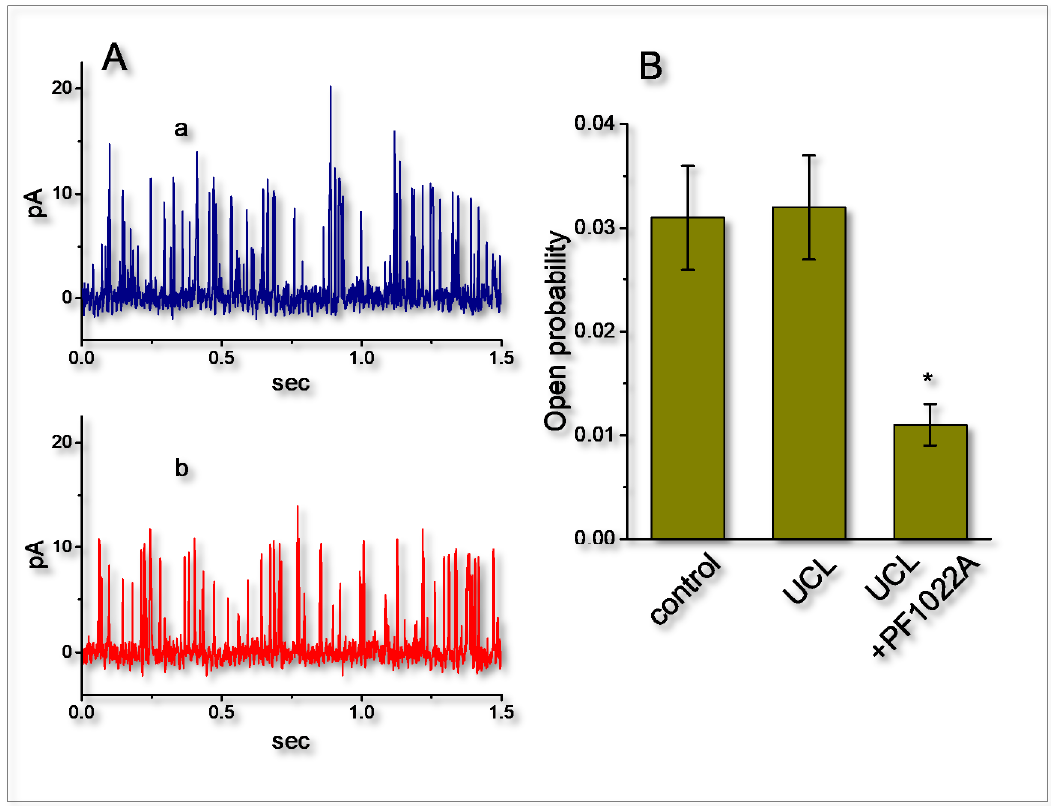
Figure 6. Failure of UCL-2077 to perturb the activity of BK Ca channels functionally expressed in GH 3 cells. In these experiments, inside-out current recordings were made, cells were bathed in high-K + , Ca 2 + -free solution, bath solution contained 0.1 µ M Ca 2 + and the examined cell was held at + 60 mV. ( A ) Original BK Ca -channel currents obtained in the absence (a) and presence (b) of 10 µ M UCL-2077. The upward deflection is the opening event of the channel. ( B ) Bar graph depicting e ff ects of UCL-2077 (10 µ M) and UCL-2077 (10 µ M) plus PF1022A (10 µ M) on the probabilities of BK Ca channels that would be actively open (mean ± SEM, n = 8 for each bar). * denotes significant di ff erence from control ( p <